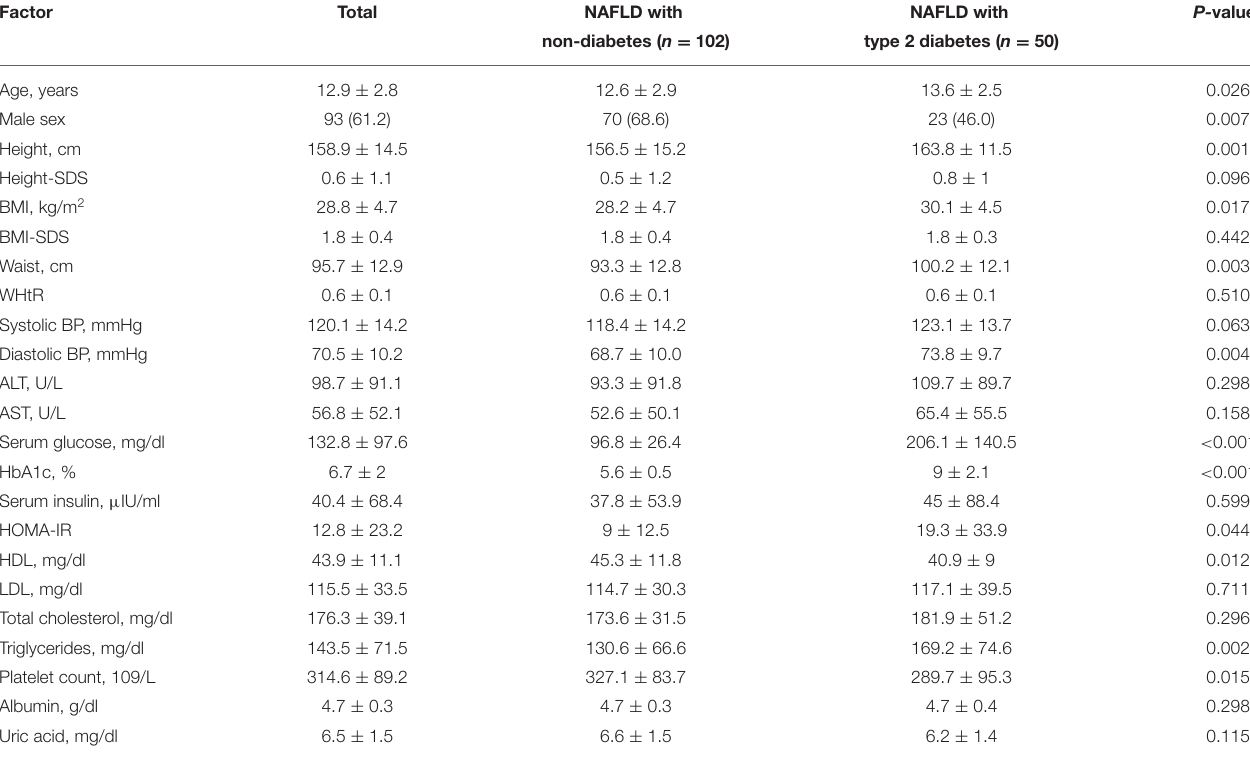
TABLE 1 | Major clinical and biochemical characteristics of children/adolescents with NAFLD.